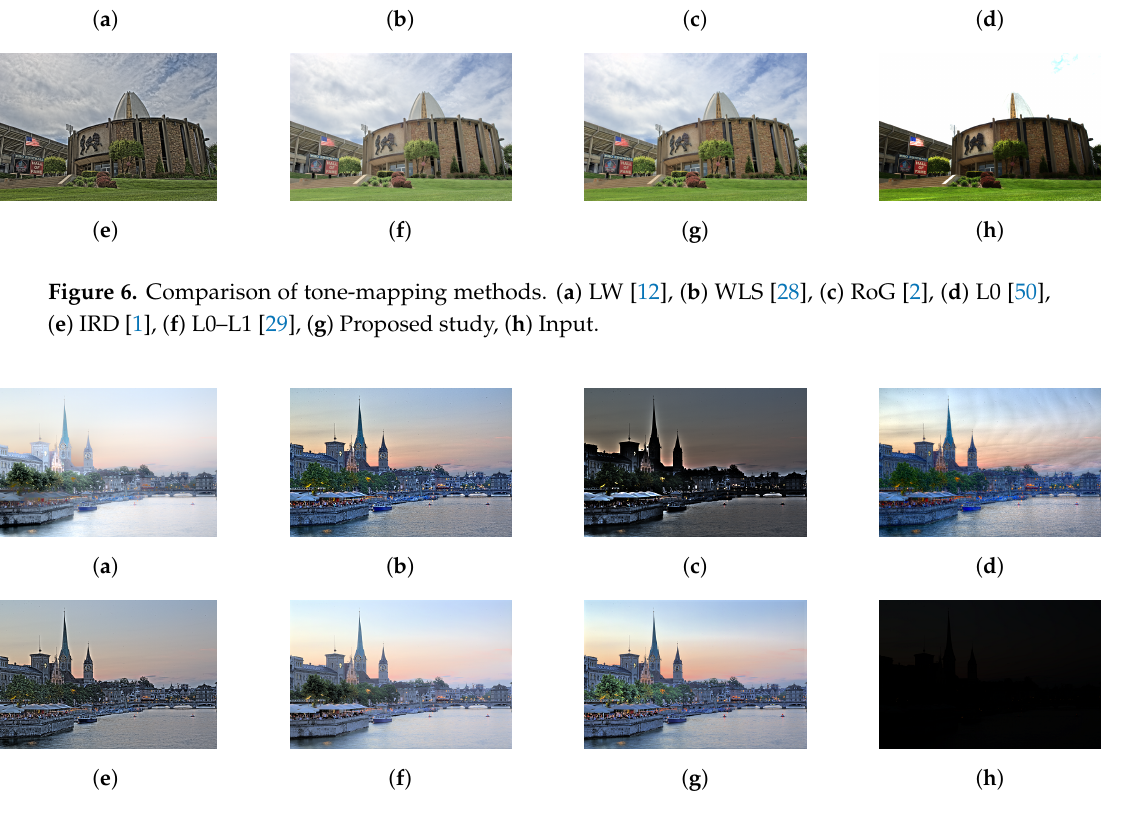
Figure 7. Comparison of tone-mapping methods. ( a ) LW [12], ( b ) WLS [28], ( c ) RoG [2], ( d ) L0 [50],